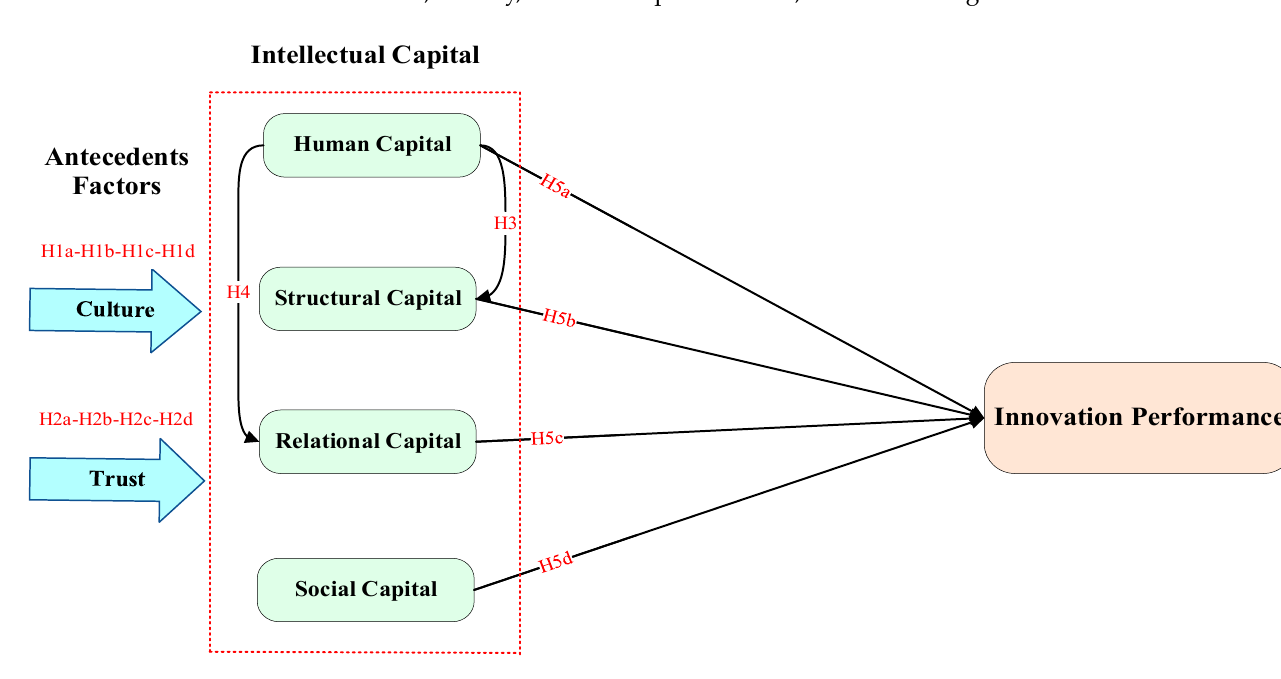
Figure 1. Conceptual framework of the present research.